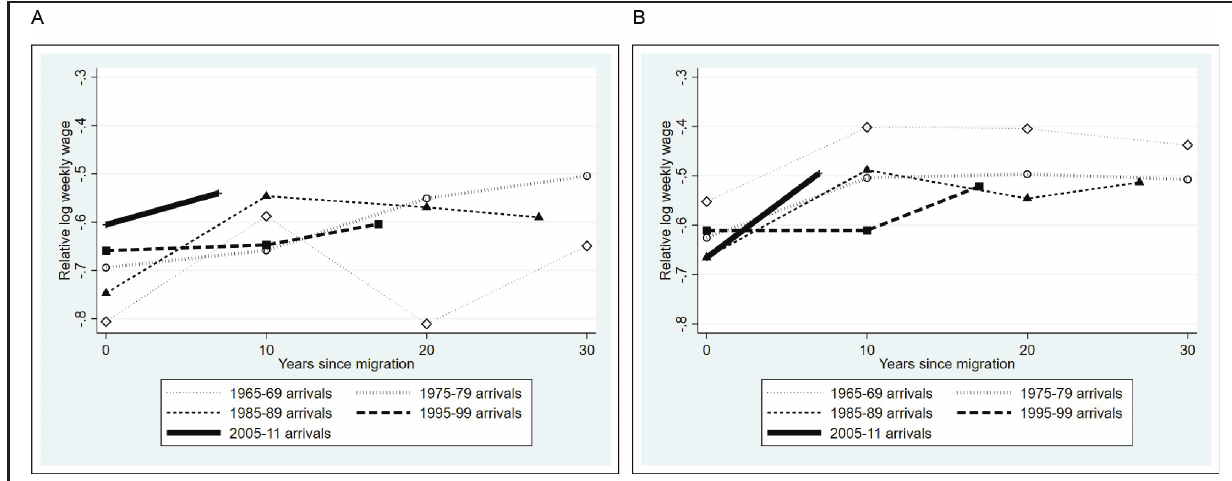
Figure 5 Age-adjusted convergences for the relative log weekly earnings of Mexican and Central American immigrant cohorts by enclave region: initial gaps and convergences. (A) enclave; (B)